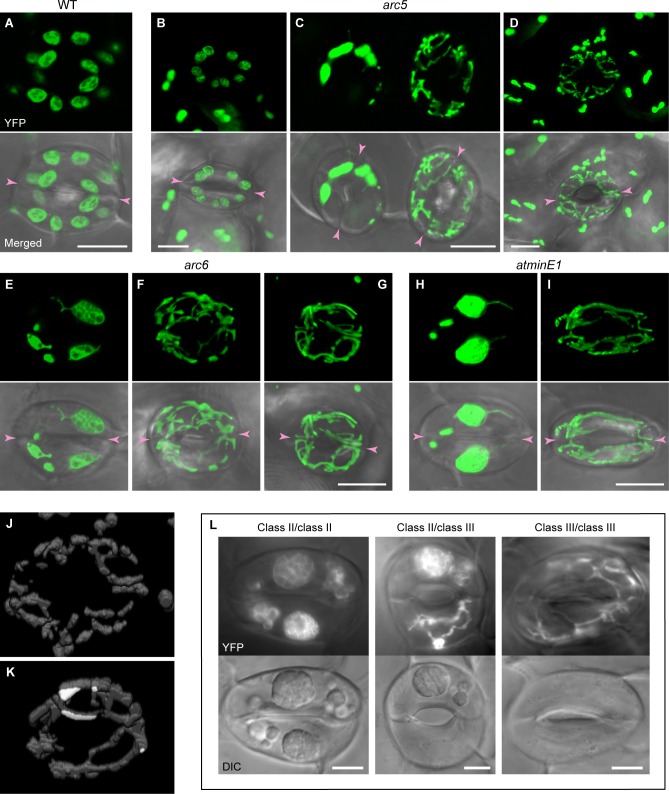
Plastid phenotypes in leaf stomatal GCs in Arabidopsis WT, arc5, arc6, and atminE1 plants.(A–I) Images of plastid-targeted YFP in the third-fourth leaf petioles of 4-week-old seedlings from the WT (A), arc5 (B–D), arc6 (E–G), and atminE1 (H, I). CLSM images of maximal intensity projection (top panels) and merged with DIC (bottom panels) are shown. (J, K) Images of YFP-labeled plastids in GCs reconstructed from a series of optical sections generated by CLSM, taken at 0.3 or 0.6 μm intervals. The GC pairs in panels (J) and (K) are identical to those in panels (D) and (G), respectively. (L) Epifluorescence microscopy images of GCs in the third-fourth leaf petioles of 4-week-old seedlings from arc6. Images of YFP (top panels) and DIC (bottom panels) are shown. Bar = 10 μm.